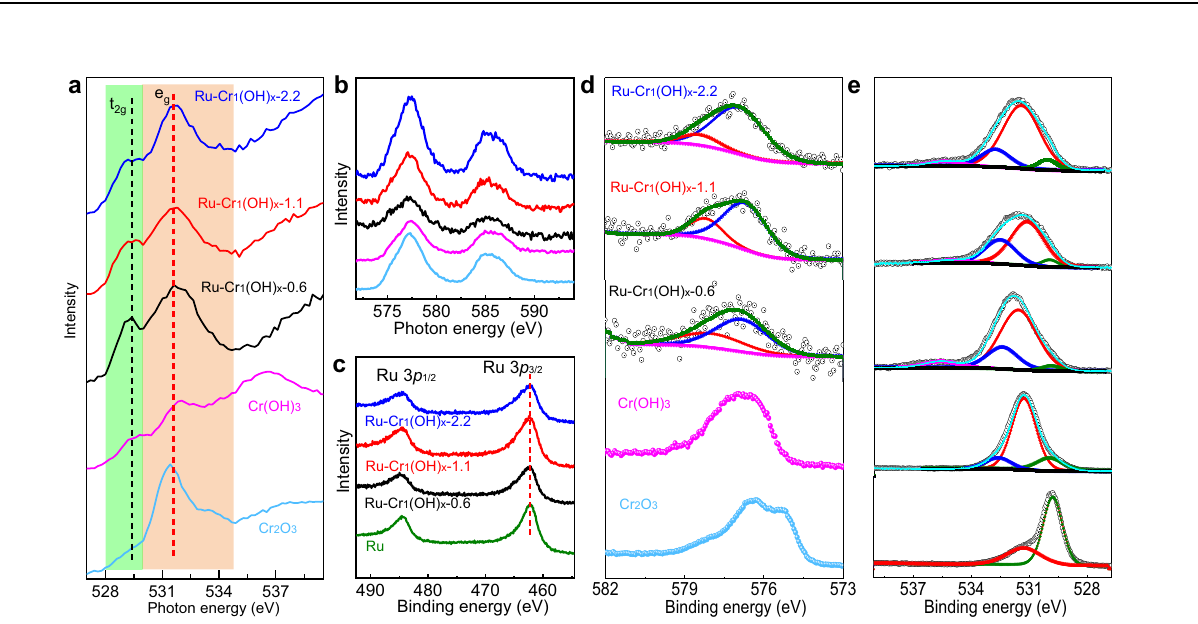
FT-EXAFSspectrain R -space.EXAFS fi tting curves of Ru – Cr 1 (OH) x − 1.1 in R ( c )and k ( d ) space. e WT for the k 3 -weighted EXAFS of different samples.